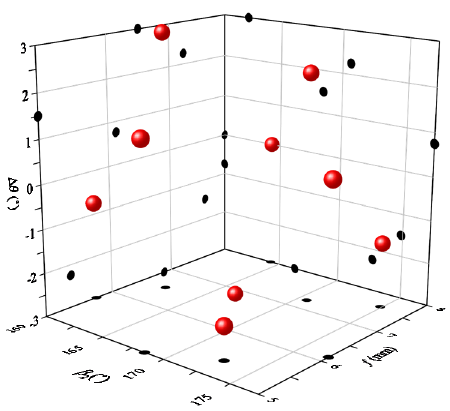
Figure 9. Three-dimensional diagram of initial sample points.